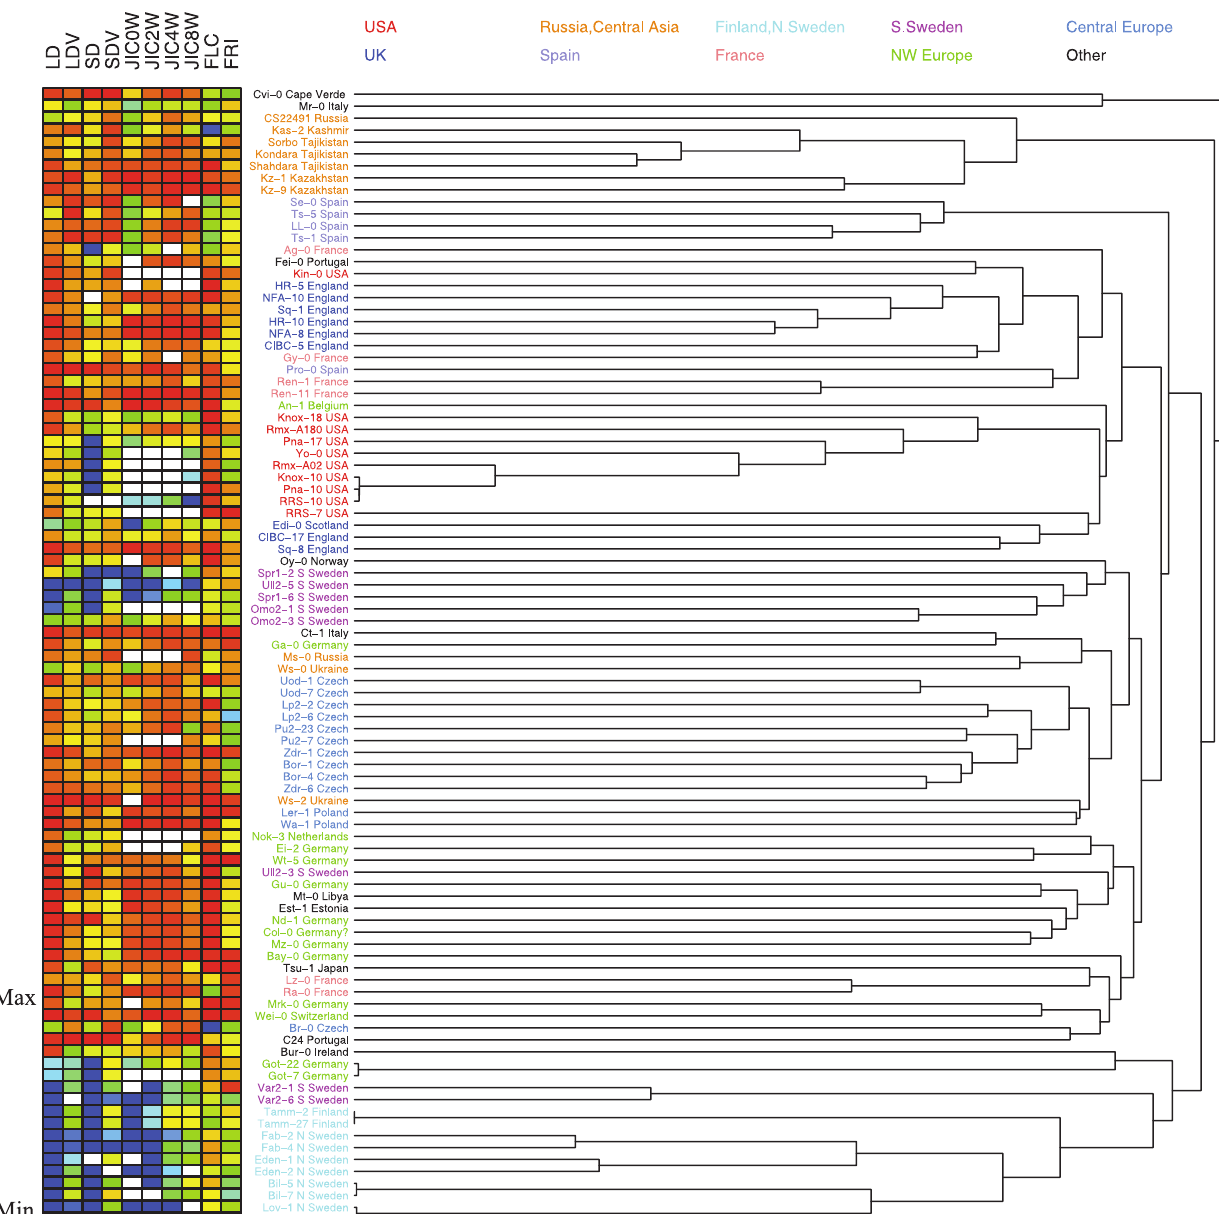
Figure 1. Summary of the Data Illustrating Strong Positive Correlations between Phenotypes and between Phenotypes and Genome-Wide Relatedness The panel on the left gives the basic phenotypes used (see Table 1), with colors indicating relative values within each phenotype (white denotes missing data). The tree on the right shows a hierarchical clustering (UPGMA) of accessions based on their relative kinship (as measured by pairwise haplotype sharing). Colors for the accessions labels indicate geographic origins.